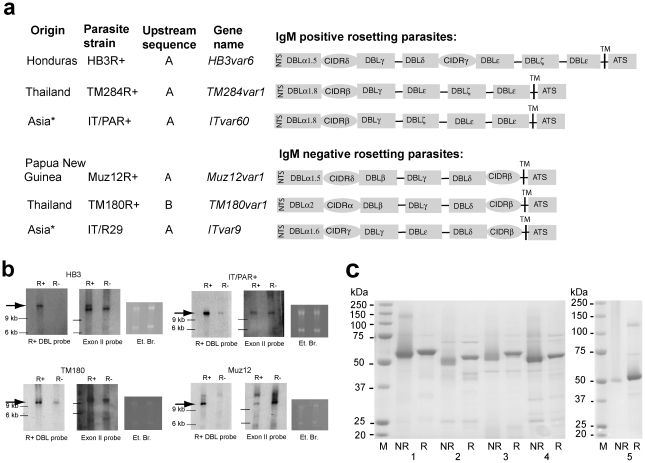
Identification of key surface antigens (Group A PfEMP1 variants) of P. falciparum rosetting parasites and production of recombinant proteins for immunization.a) PfEMP1 domain architecture of the predominantly expressed variants from P. falciparum rosetting laboratory strains. The previously described rosetting variant ITvar9 [13], [22], [45] is shown for comparison. Domain types are based on conserved motifs [6], [51]. NTS: N-Terminal Segment; DBL: Duffy Binding Like; CIDR: Cysteine-rich InterDomain Region; ATS: Acidic Terminal Segment; TM: TransMembrane region. *The IT isolate was originally from Brazil, however following cross-contamination of parasite cultures in the early1980s, current IT/FCR3 strains are thought to be of South-East Asian origin [88]. The Genbank accession numbers for these sequences are Y13402 (ITvar9/R29var1), EF158099 (ITvar60), JQ684046 (TM284var1), JQ684047 (TM180var1) and JQ684048 (Muz12var1). The HB3var6 sequence can be obtained from http://www.broadinstitute.org/annotation/ genome/plasmodium_falciparum_spp/MultiHome.html gene reference PFHG_02274.1. b) Northern blots of RNA from isogenic rosetting (R+) and non-rosetting (R−) parasites probed with a PfEMP1 domain from the rosette-specific variant for each strain (R+ DBL probe, high stringency) and with an Exon II probe (moderate stringency), which detects all var genes [50]. Arrows indicate the major rosette-specific var gene transcript in each strain. Equal loading of R+ and R− RNA was confirmed by staining with ethidium bromide (Et Br). c) Production of recombinant NTS-DBLα domains in E. coli to immunize rabbits. 1: TM180var1, 2: Muz12var1, 3:TM284var1, 4: ITvar60, 5:HB3var6. M: molecular weight marker; R: reduced; NR: non-reduced.